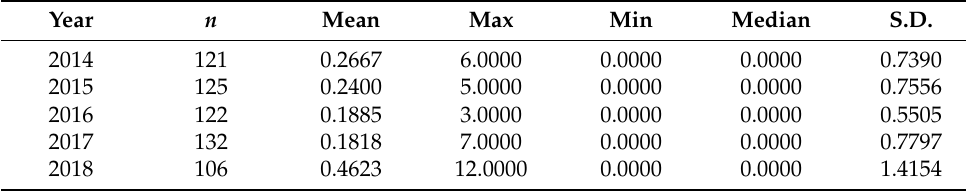
Table 3. Descriptive statistics on the number of media reports.